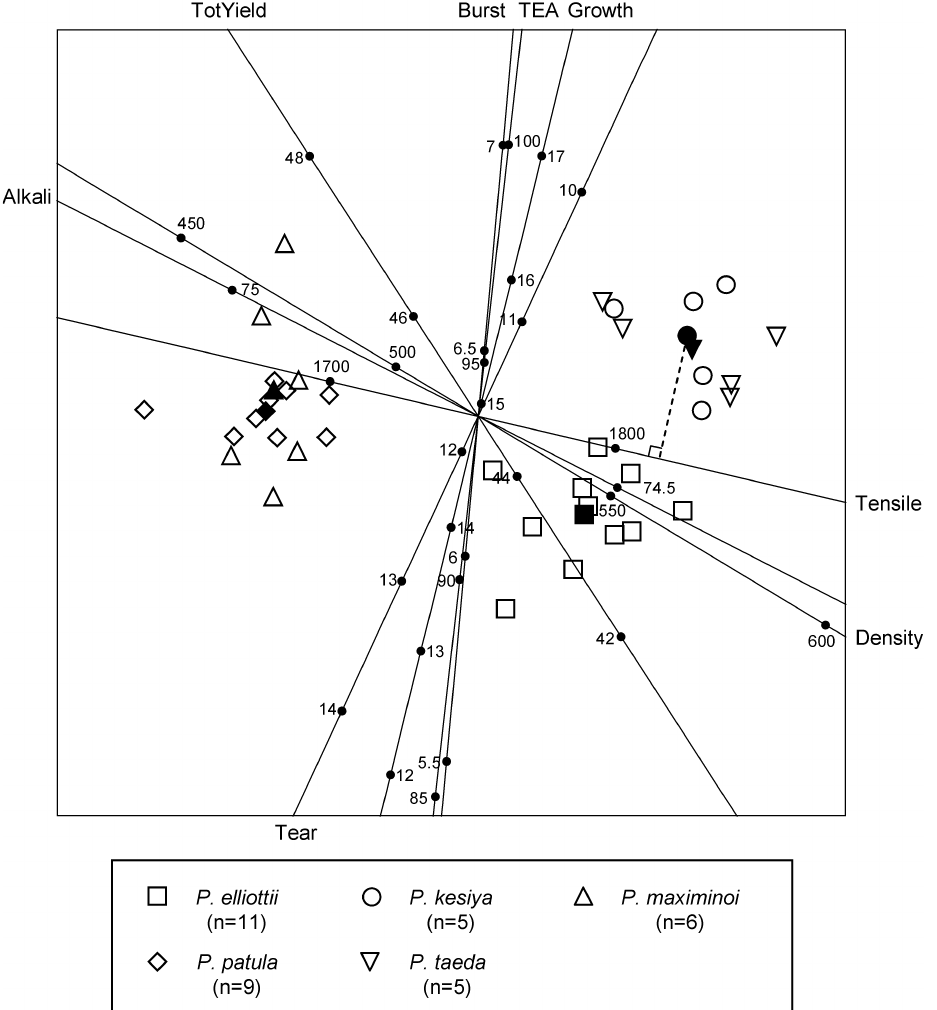
Figure 2: CVA biplot of the pine species with group means shown as solid symbols respectively. • The biplot in Figure 2, unlike Figure 1, provides suggestions as to which of the variables contribute to separation between the five species: e.g. the variable Burst separates relatively high valued P. kesiya and P. taeda from relatively low valued P. elliottii with P.